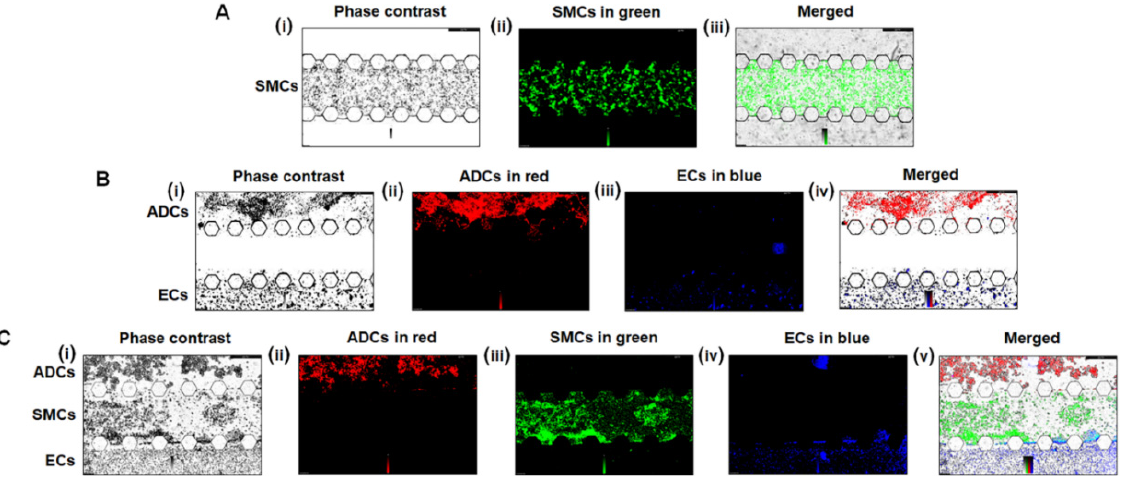
Figure 7. LEICA microscope images of cell seeding in chips with hexagonal pillars. ( A ) Smooth muscle cells (SMCs; loaded with green fluorescence cell trackers) seeded in the medial layer without any leaks into the adventitial or intimal layers, ( i ) Brightfield image of SMCs, ( ii ) Green fluorescence image of SMCs, and ( iii ) Merged image. ( B ) Adventitial cells (ADCs; loaded with red fluorescence cell trackers) seeded in adventitial layer and endothelial cells (ECs; loaded with blue fluorescence cell trackers) seeded in the intimal layer without any leaks in the medial channel or the growth media reservoirs (not shown due to magnification limitations), ( i ) Brightfield image of ADCs and ECs, ( ii ) Fluorescent image of ADCs, ( iii ) Fluorescent image of ECs, and ( iv ) Merged image. ( C ) ADCs seeded in adventitial layer, SMCs seeded in medial layer, and ECs seeded in the intimal layer without any leaks to the growth media reservoirs (not shown due to magnification limitations), ( i ) Brightfield image of ADCs, SMCs and ECs, ( ii ) Fluorescent image of ADCs, ( iii ) Fluorescent image of SMCs, ( iv ) Fluorescent image of ECs, and ( v ) Merged image.